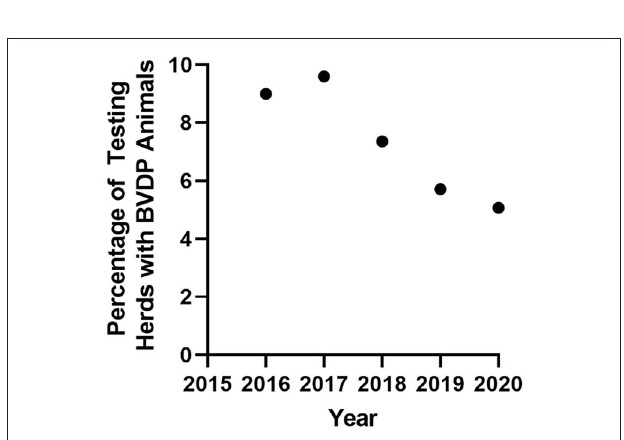
FIGURE 3 | The annual incidence of testing herds with animals disclosing as BVDv positive